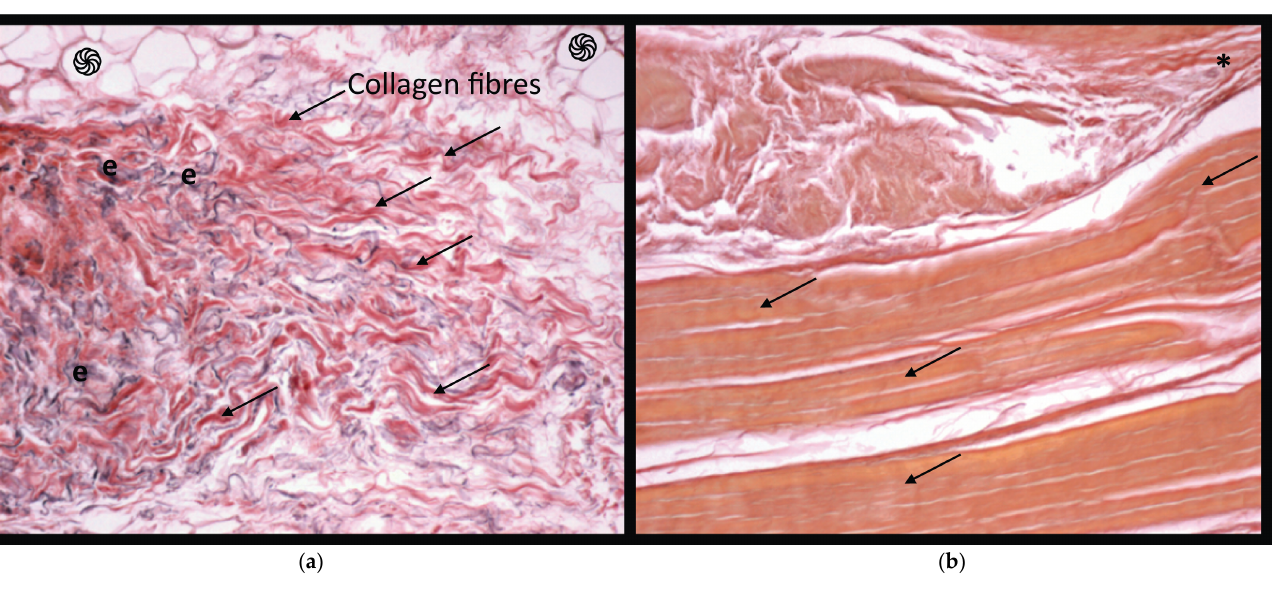
Figure 2. Weigert–Van Gieson staining for elastic fibres used for ( a ) retinacula and ( b ) patellofemoral ligament (10×) biopsy sections, respectively. By this colouration technique, it was possible to identify bundles of collagen fibres (arrows), adipocytes ( ֍ ), elastic fibres (in violet, e), fibrocytes and small blood vessels (*).